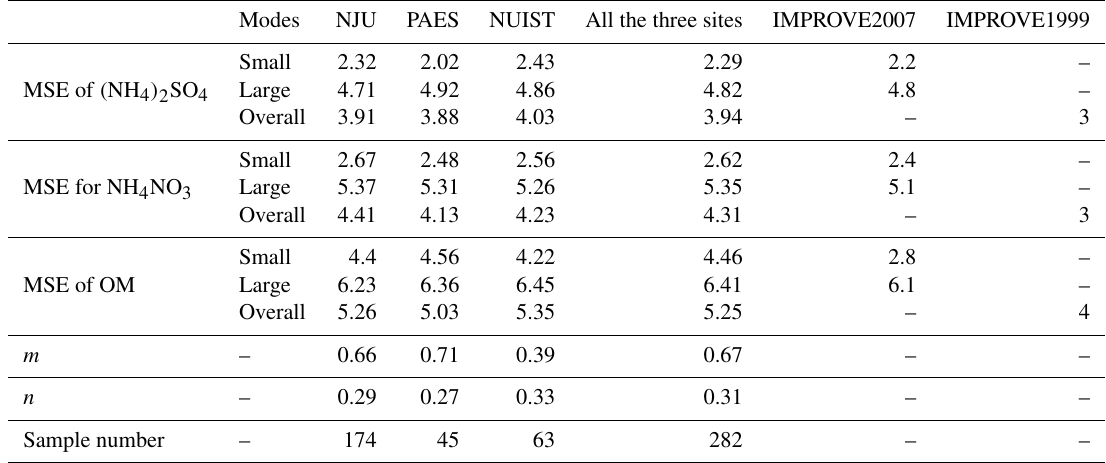
Table 2. The mass scattering efficiencies (MSEs; m 2 g − 1 ) of chemical species in the optimized and the existing algorithms from the Inter- agency Monitoring of Protected Visual Environments (IMPROVE). The sample numbers and the mass fractions of light absorption BrC to MSOC for small- and large-size modes (i.e., m and n in Eq. 1) are provided for the optimized algorithm. Modes NJU PAES NUIST All the three sites